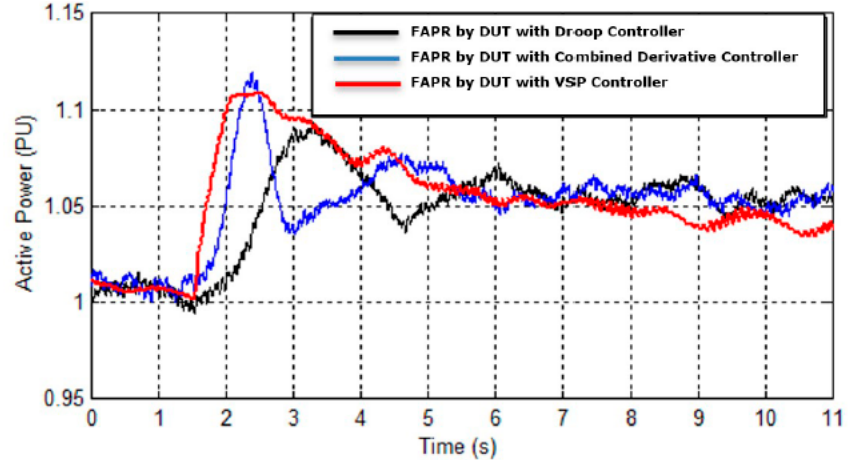
Figure 13. Comparison among FAPR controllers.